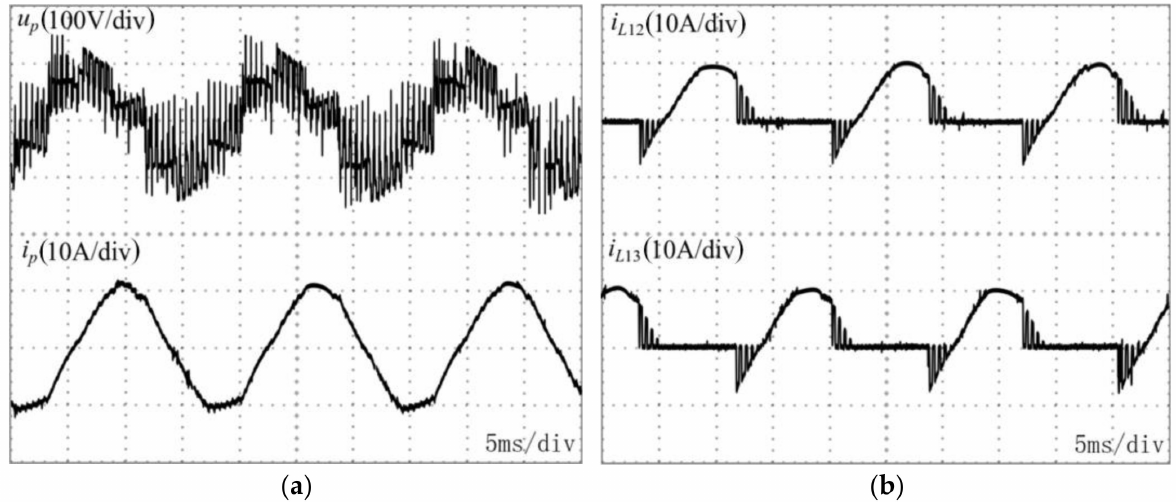
Figure 11. Waveforms of ( a ) phase voltage u p , phase current i p , and ( b ) currents of inductors L12 and L13 measured at a switching frequency of 1 kHz when the inverter supplied the star-connected inductive-resistive load; the operation parameters are the same as those in Figure